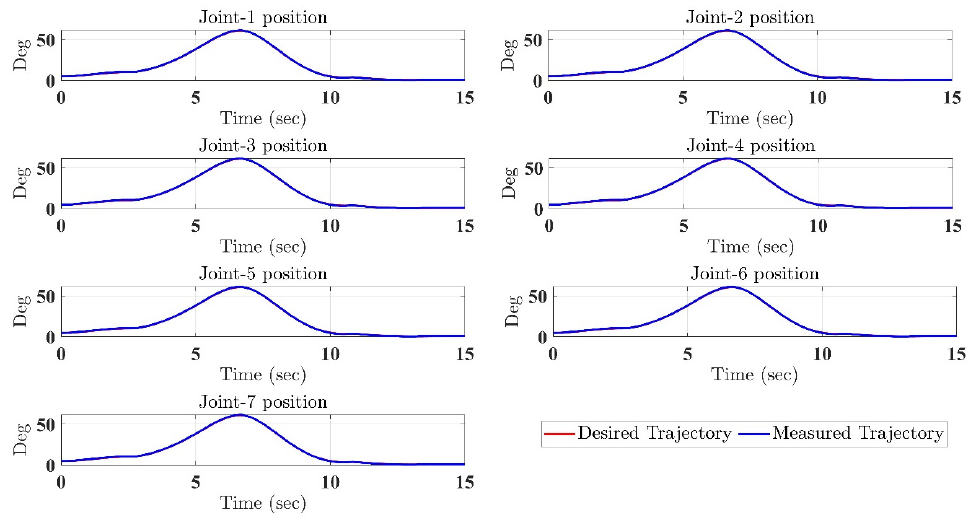
Figure 6. SRex’s trajectory tracking in joint space under the proposed controller (corresponding to Cartesian Trajectory given in Figure 4).